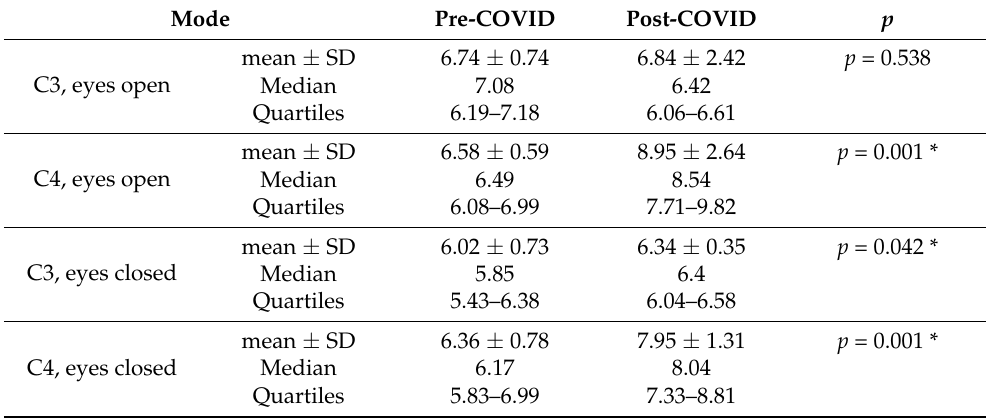
Table 3. The results of the Alpha waves examination (waves from C3, C4 channels).